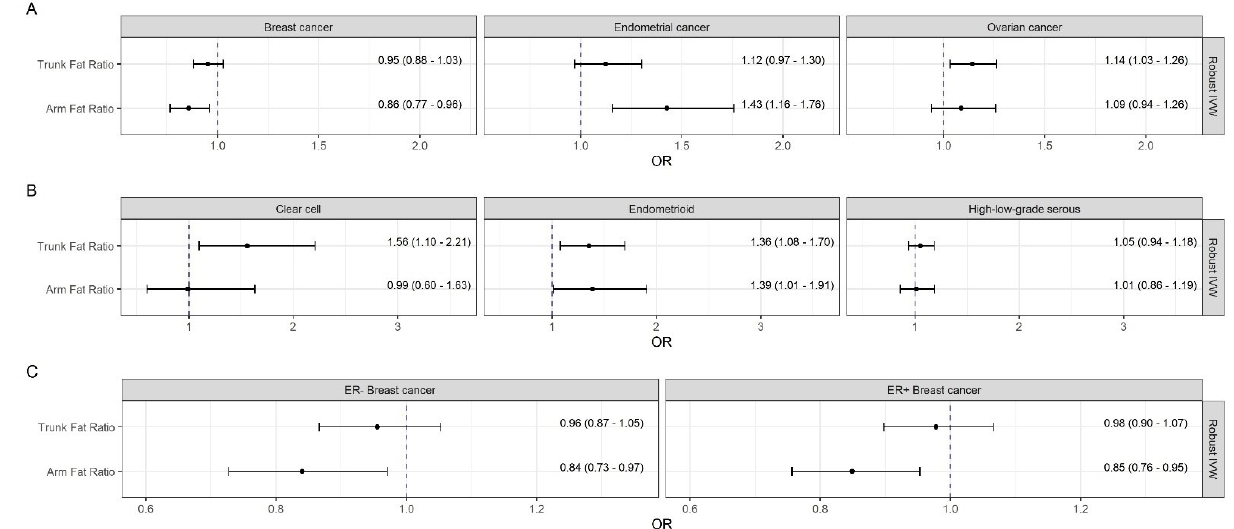
Figure 2. Mutually adjusted causal estimates (odds ratios and 95% confidence intervals per one SD change in the appropriate exposure) from multivariable Mendelian randomization analyses of genetically predicted trunk and arm fat ratios on female-specific cancers. Abbreviations: IVW, inverse-variance weighted; OR, odds ratio.